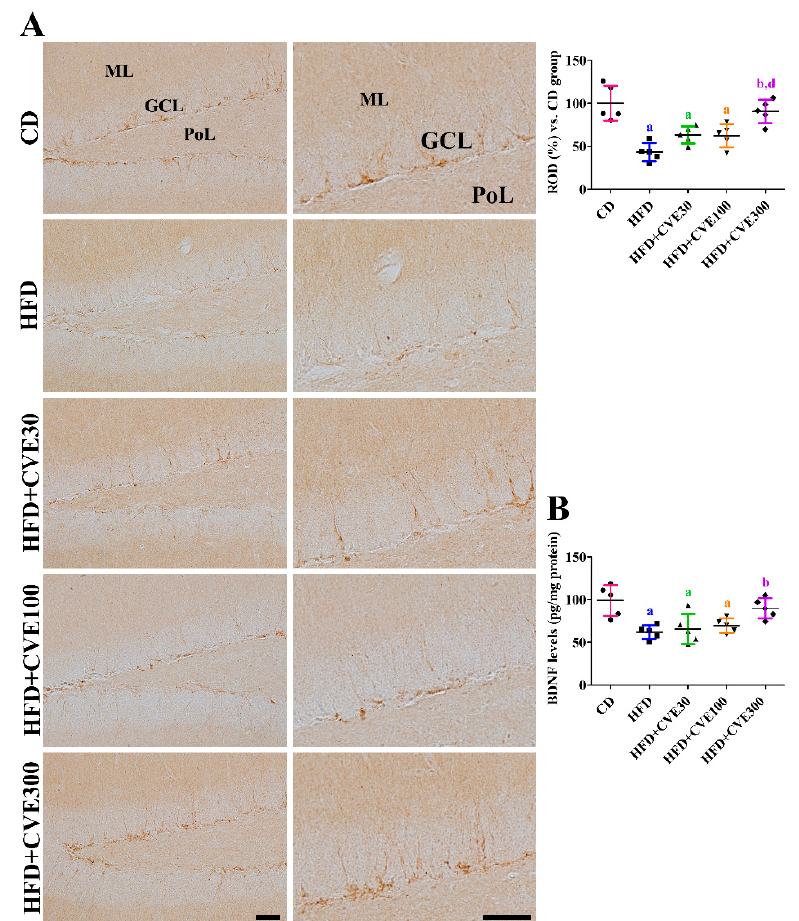
Figure 5. Immunohistochemical staining for DCX ( A ) and measurement of BDNF ( B ) in the CD, HFD, HFD+CVE30, HFD+CVE100, and HFD+CVE300 groups at 8 weeks after treatment. Optical density was calculated based on pixel number with gray density, and ROD is demonstrated vs. the CD group. The data were analyzed using one-way analysis of variance followed by Bonferroni’s post hoc test ( a p < 0.05, significantly different from the CD group; b p < 0.05, significantly different from the HFD group; d p < 0.05, significantly different from the HFD+CVE100 group). The bars indicate the mean ± standard deviation. CD, control diet; CVE, Cissus verticillata leaf extract; DCX, doublecortin; HFD, high-fat diet; ROD, relative optical